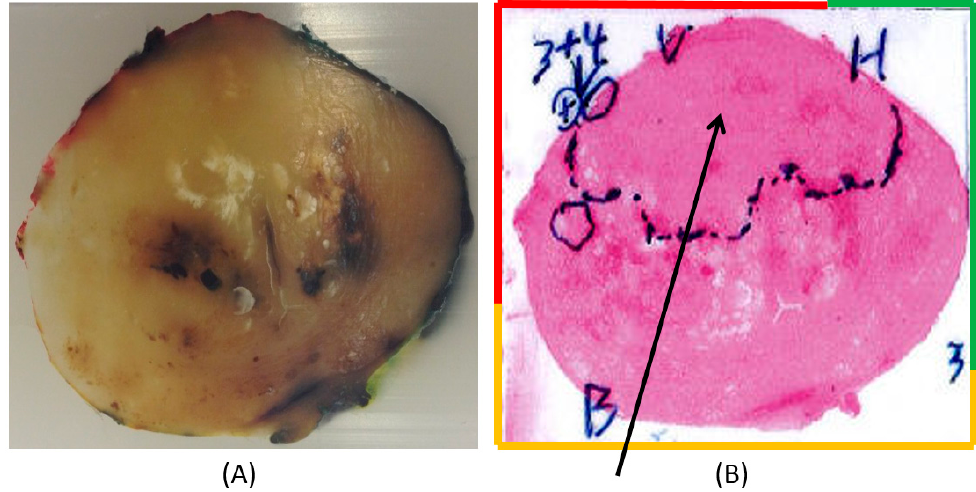
Figure 12. A slice of Prostate 2 (P-2). The diameter of P-2 was 40 mm. ( A ) A slice embedded in paraffin and stained at the periphery in order to locate the left anterior (red), right anterior (green), and dorsal (yellow) parts of the prostate. ( B ) Scanned photomicrograph of a section of the corresponding prostate slice. The arrow points out a large area marked by the pathologist in the anterior aspect containing cancer. In the left anterior, a tumor with a Gleason score of 7 (3 + 4) is also pointed out.